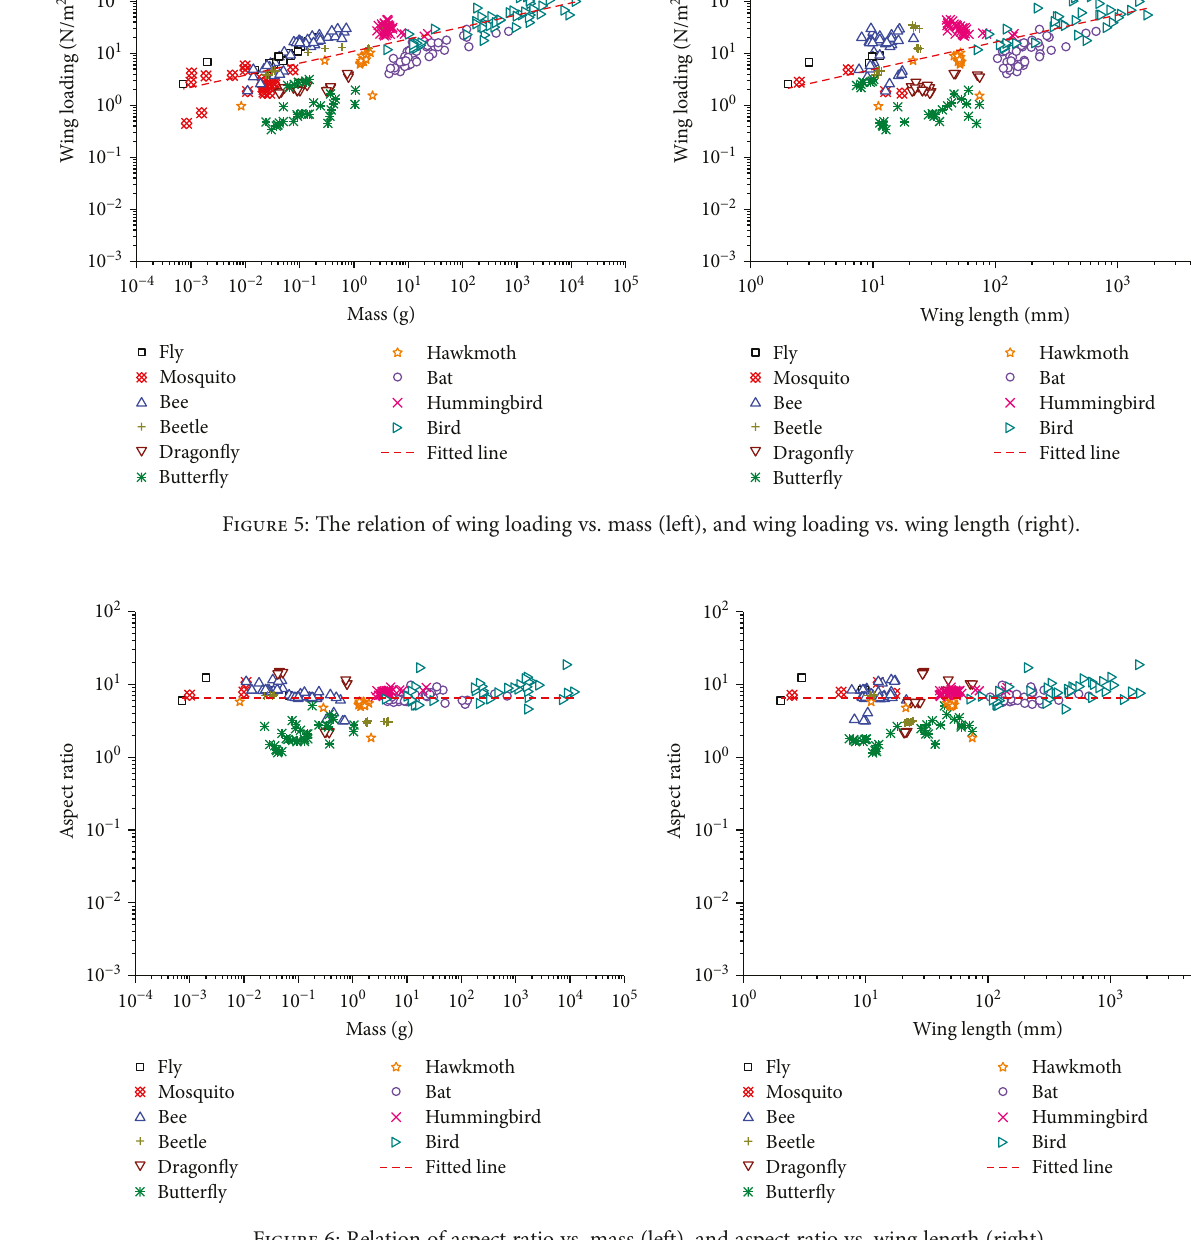
Figure 6: Relation of aspect ratio vs. mass (left), and aspect ratio vs. wing length